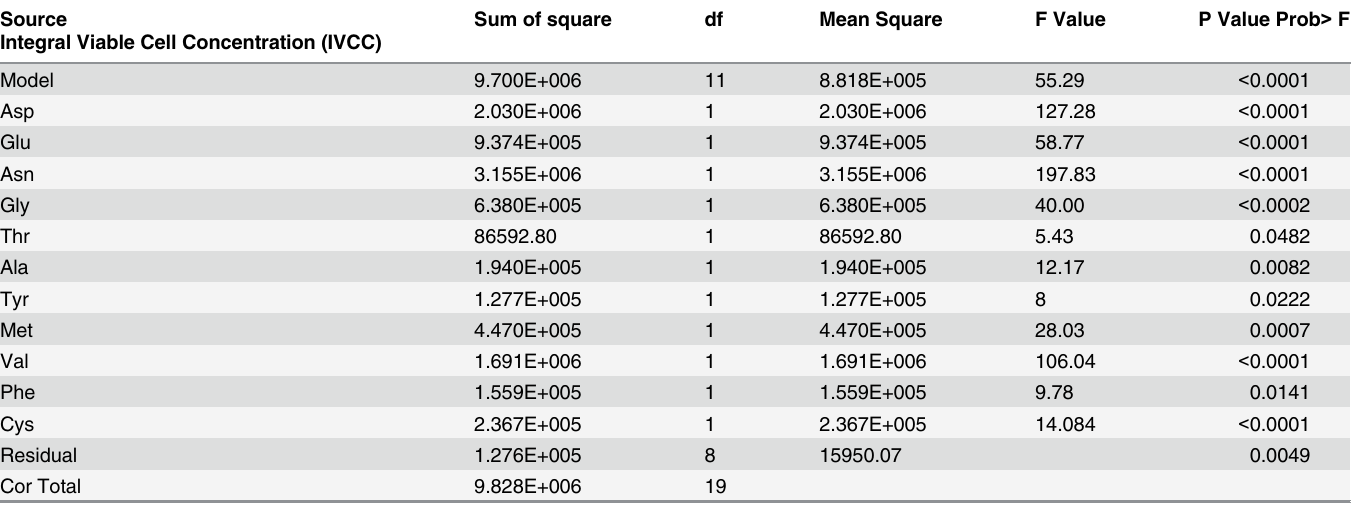
Table 6. ANOVA results for Plackett-Burman analysis for the IVCC